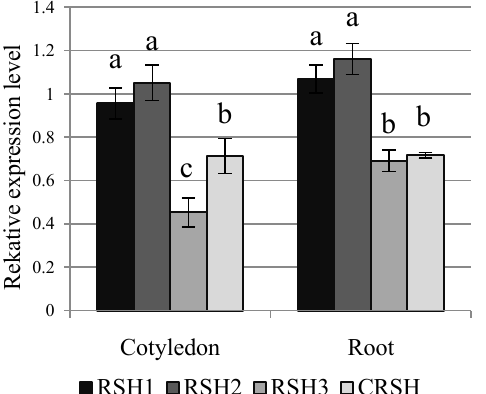
(Figure 7) in response to salt stress, and in response to the presence of PGPR bacteria (Figure 8). BnRSH genes were differentially expressed in cotyledons and roots, i.e., BnRSH1 and BnRSH2 genes were highly expressed, while BnRSH3 and BnCRSH mRNAs were expressed at a lower level in both organs.